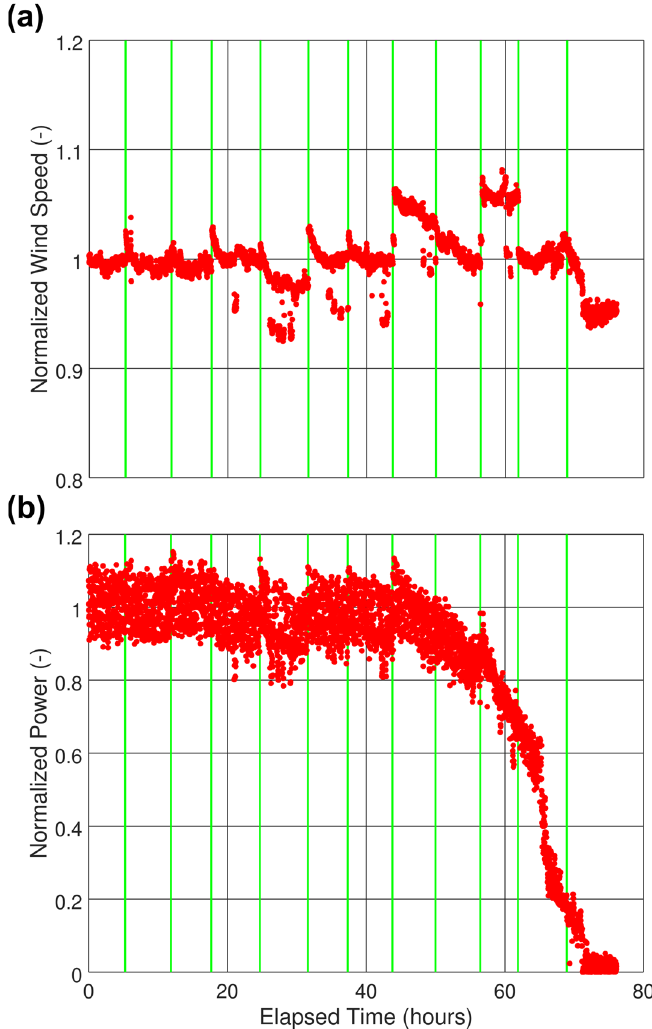
Figure 5. ( a ) Time series of normalized wind speed, and ( b ) normalized power output measured during the endurance test.